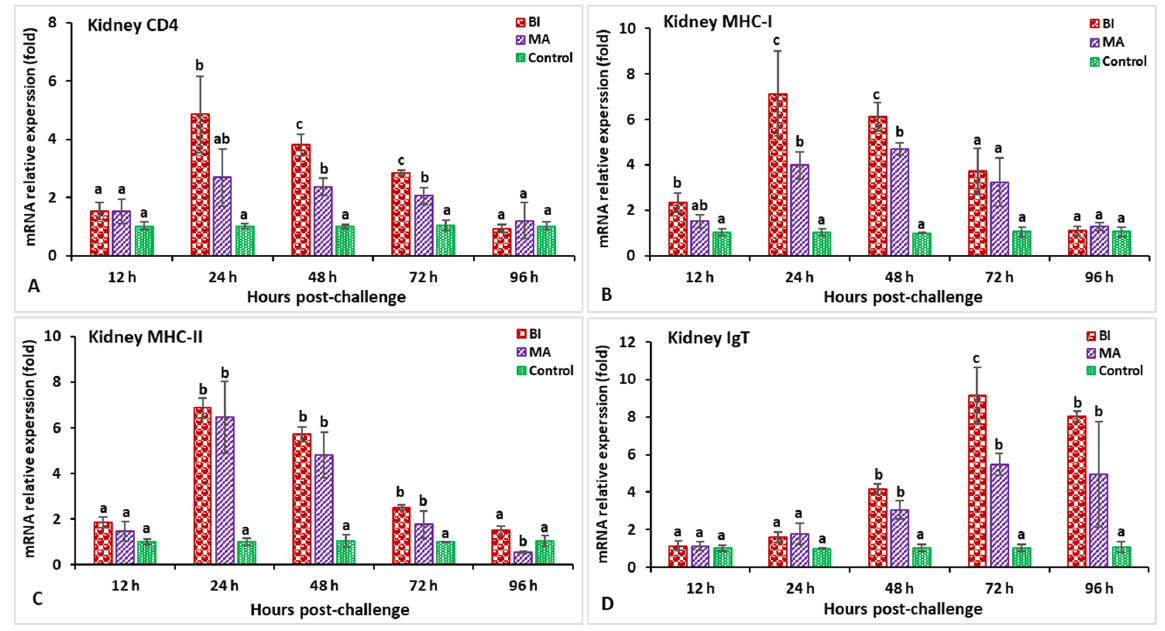
Figure 12. The gene expression of CD4 ( A ), MHC-I ( B ), MHC-II ( C ), and IgT ( D ) in the head kidneys of orally vaccinated fish after being challenged by Aeromonas hydrophila (mean ± SE, n = 3). Dissimilar letters denote significant differences ( p < 0.05).